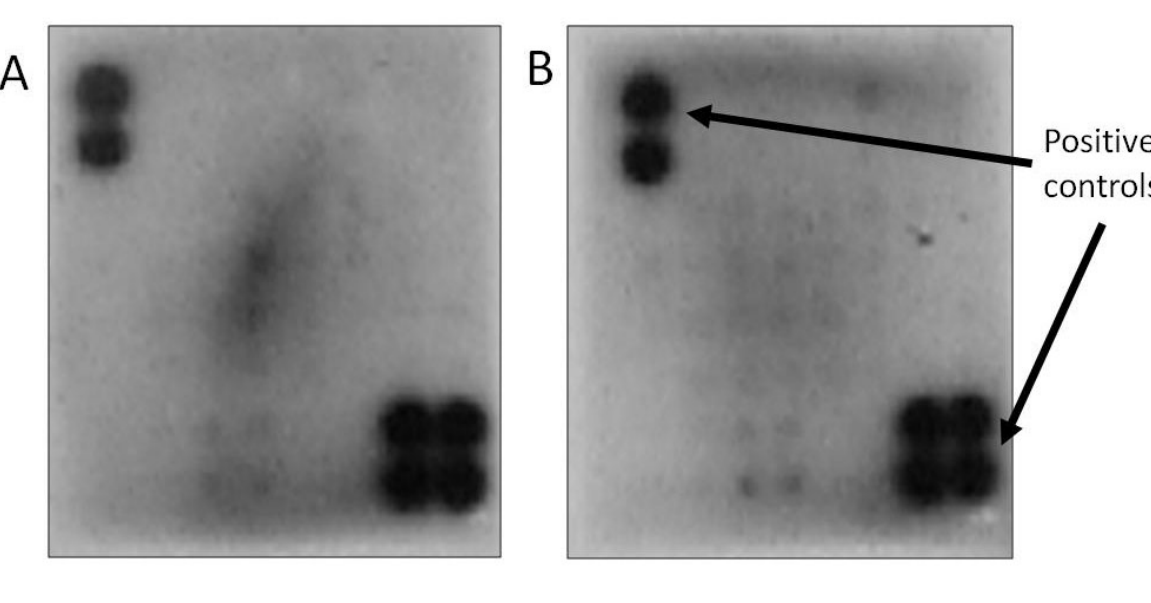
Figure 5. Cytokine expression in ( A ) absence (control) and ( B ) presence of ALT-C (50 nM). Membranes were incubated in medium from myoblast culture treated for 48 hours. Detection was performed by exposing membrane to a X-ray